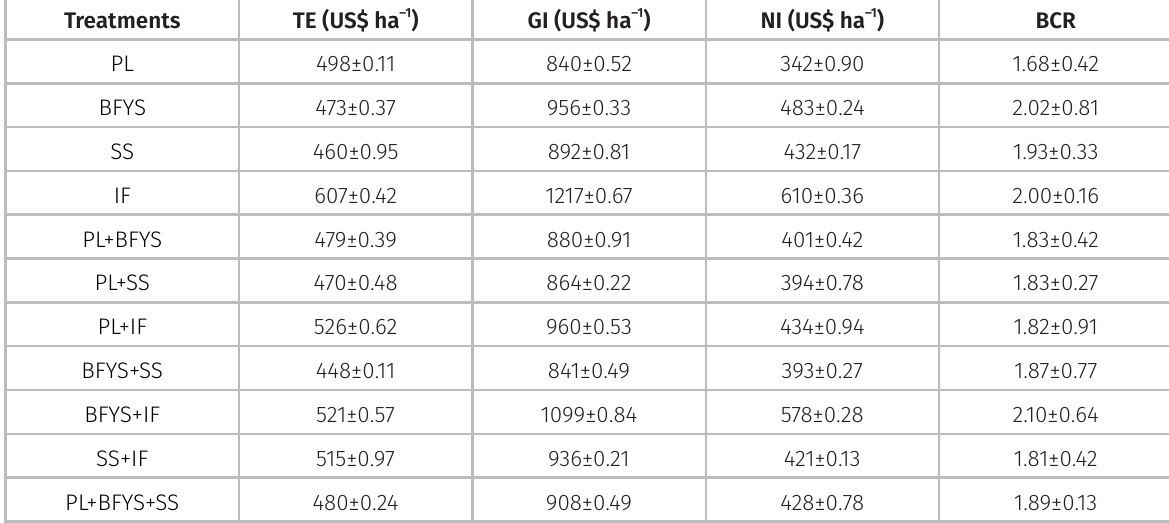
Table VII. Economic analyses of forage soybean as influenced by different chemical and organic fertilization regimes under irrigated conditions of Faisalabad,